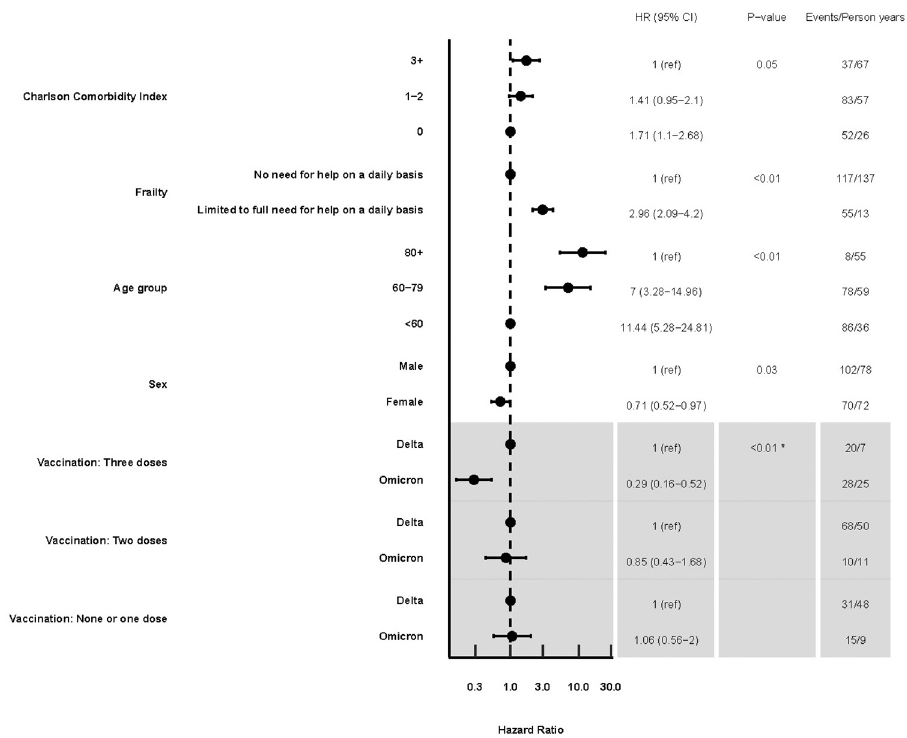
Fig 1. Multivariate hazard ratios for 60-day mortality after COVID-19 hospital admission due to SARS-CoV-2 Delta or Omicron variants in the entire study population ( n = 1,043). * The grey area indicates the results where interaction between variants and vaccination status was included in the analysis. P-value for comparing this model with interaction to one without interaction.